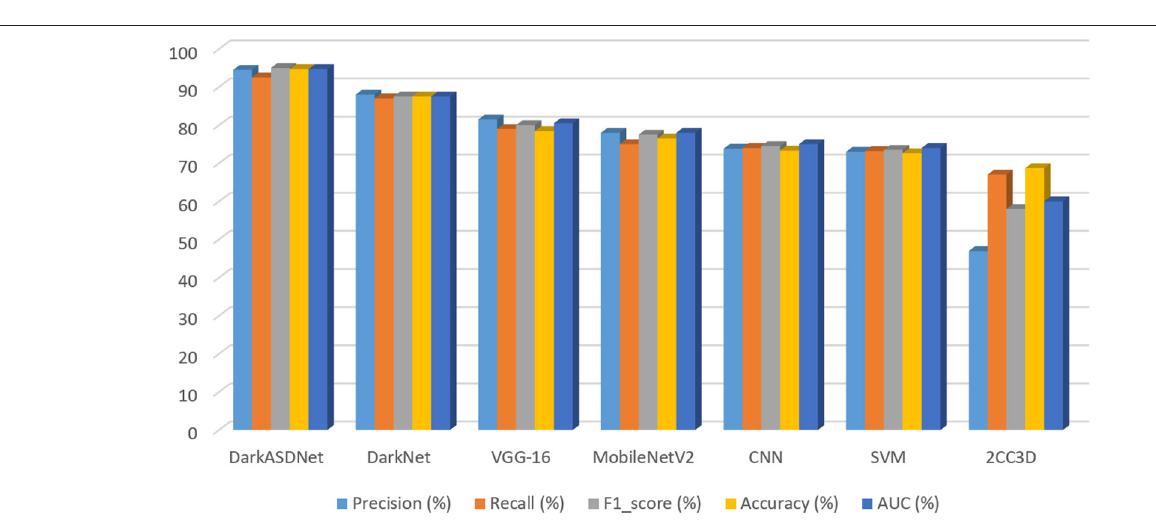
FIGURE 6 | Accuracy comparison of DarkASDNet with state-of-the-art methods used in ASD